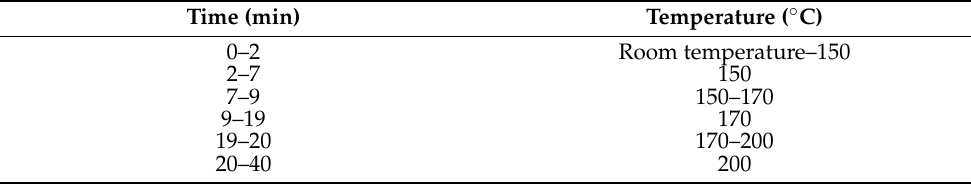
Table 2. Operating conditions of microwave-assisted acid digestion of textiles.